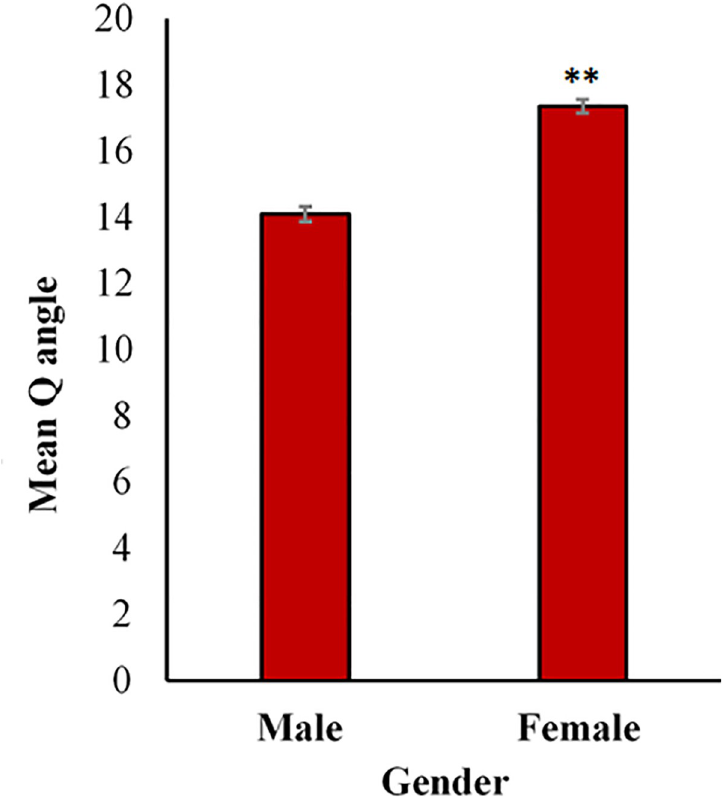
Fig 2. Variation of the Q angle with sex in adult population. The data revealed a remarkable difference in the Q angle between males and females with higher values in females. Each column represents the mean Q angle ± standard error of the mean (SE). �� P < 0.01